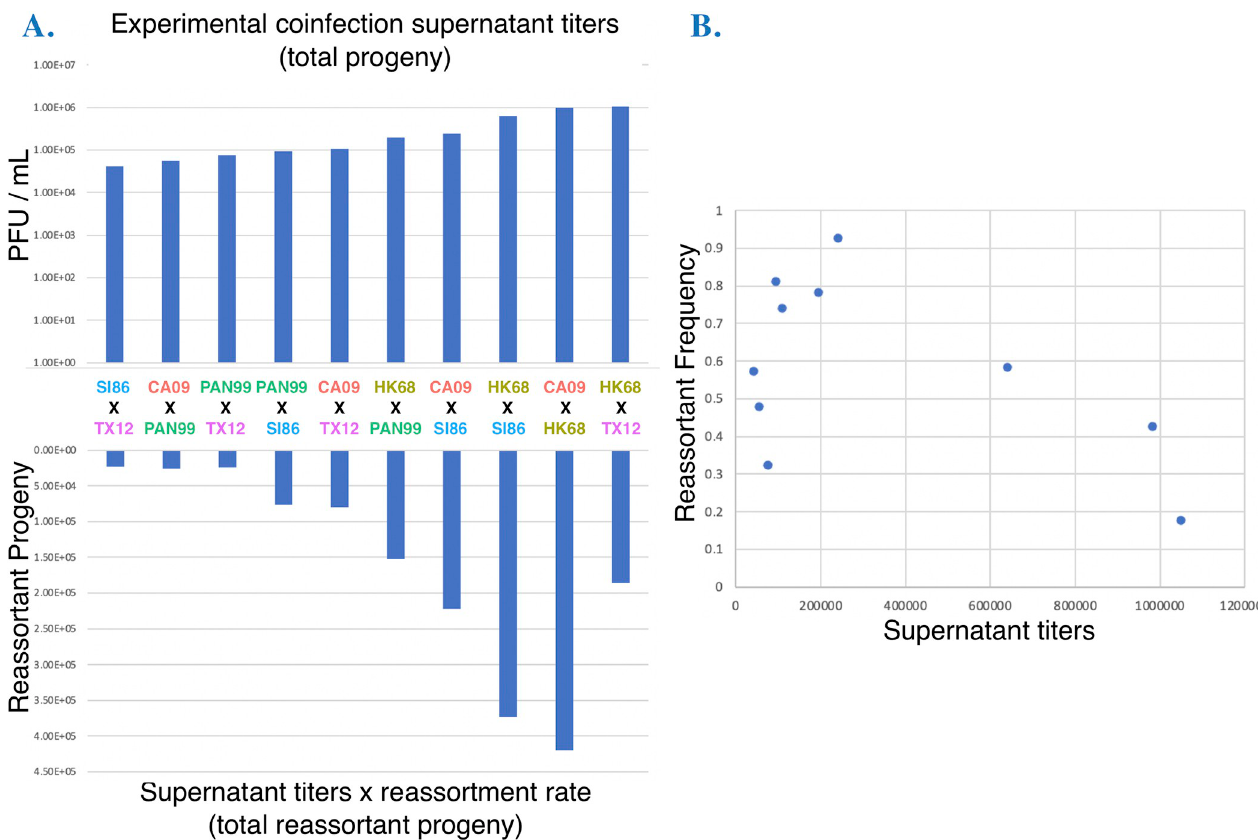
Fig 6. Viral kinetics of coinfections affect the total production of reassortants. A. Top bars show final infectious titers (PFU/mL) of each coinfection, in ascending order. Bottom bars show an estimate of the total reassortants produced by the coinfection, by multiplying the corresponding reassortment frequency for each coinfection with its titer. Note that the rank order of total progeny (top bars), and total reassortant progeny (bottom bars), and reassortment frequency (Fig 3B) is different. B. Reassortment frequency is not correlated with titers of the same experimental coinfection.